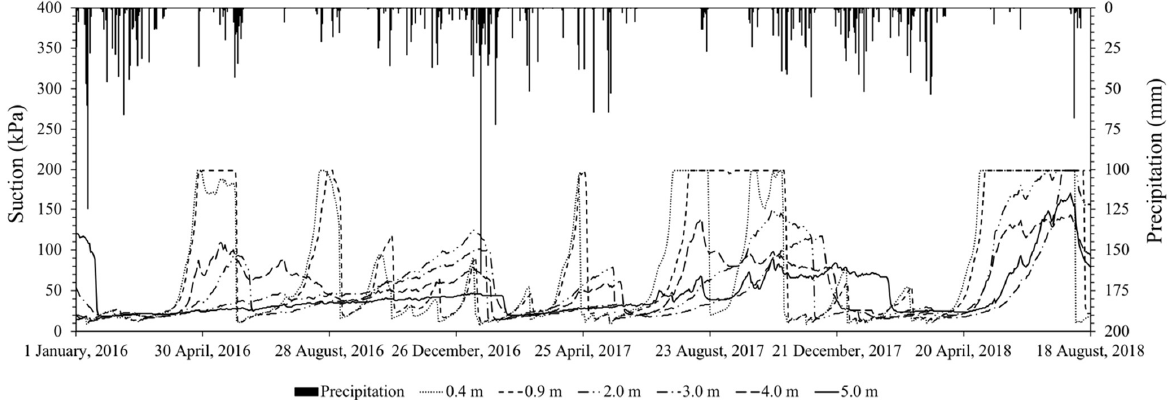
Figure 7. Suction monitoring by granular matrix sensors and precipitation data.